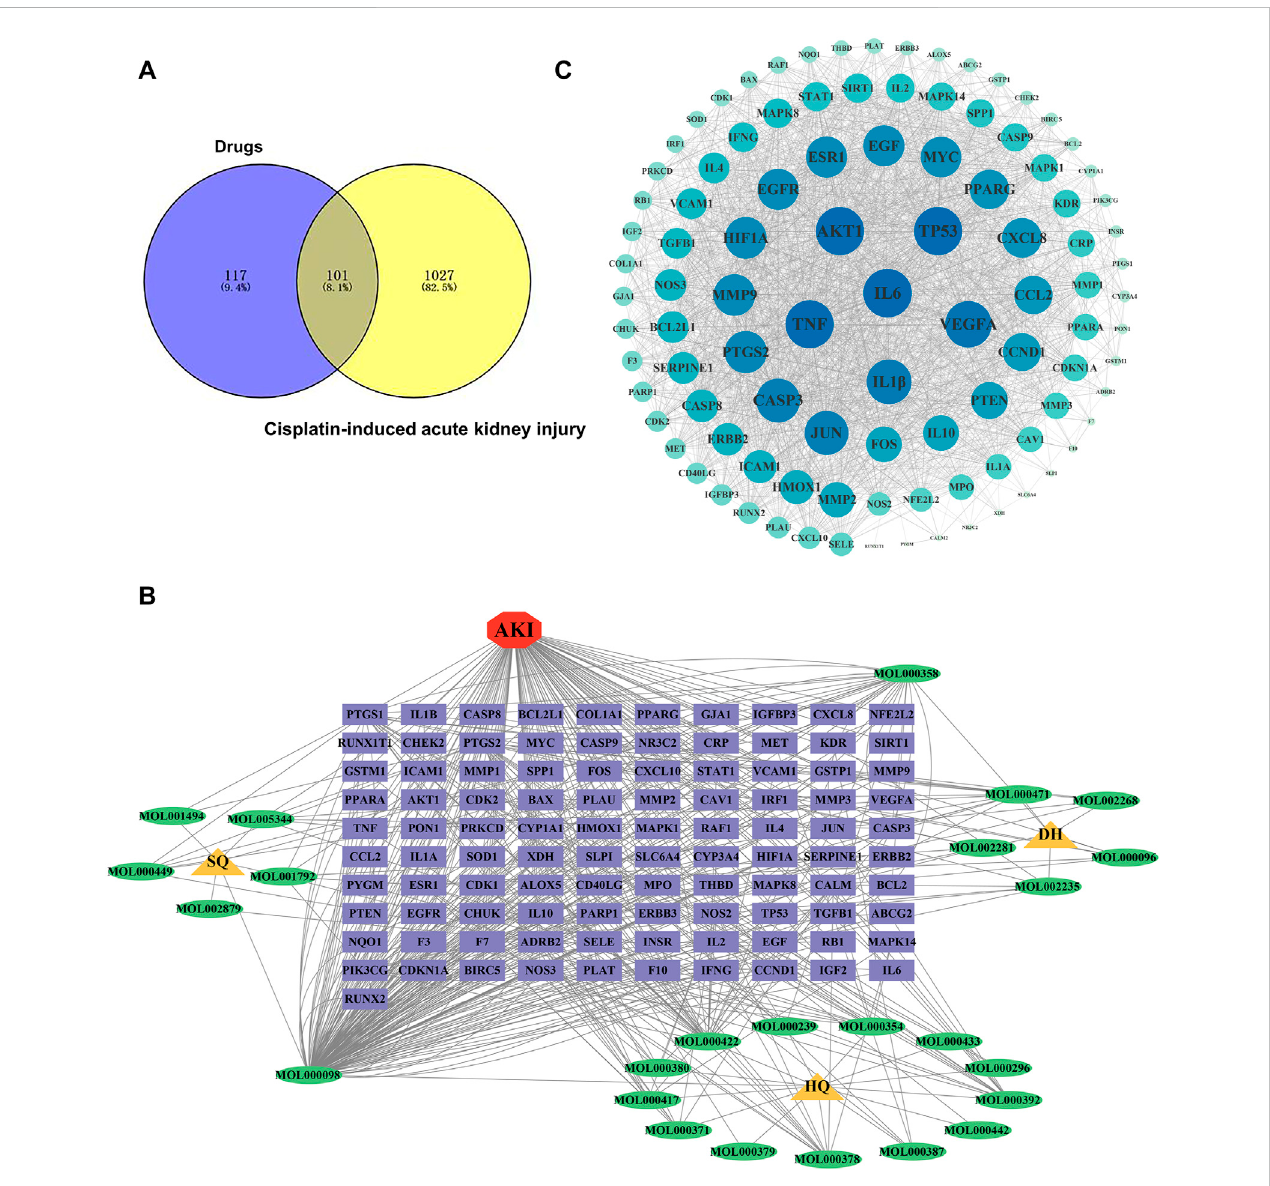
FIGURE 2 Identi fi cationofpotentialtargets-activeingredientsnetwork. (A) VenndiagramanalysisofSHDandcisplatin-inducedAKI. (B) Drug-composition-target- disease of SHD-cisplatin-induced AKI. HQ is the abbreviation of astragalus. DH is the abbreviation of rhubarb. SQ is the abbreviation of sanqi. (C) Target PPI network of SHD-cisplatin-induced